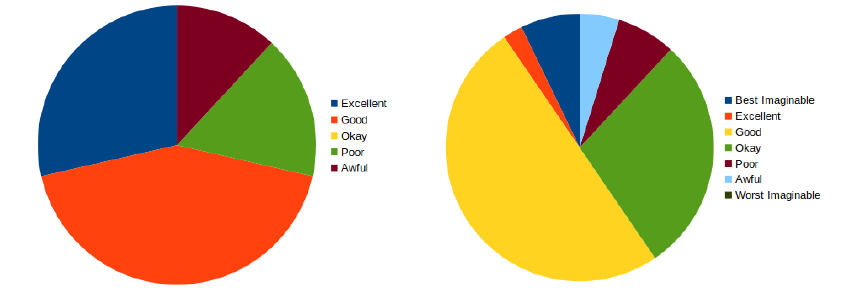
Figure 5. SUS results: ( left ) using classic scale [40], ( right ) updated approach [41].